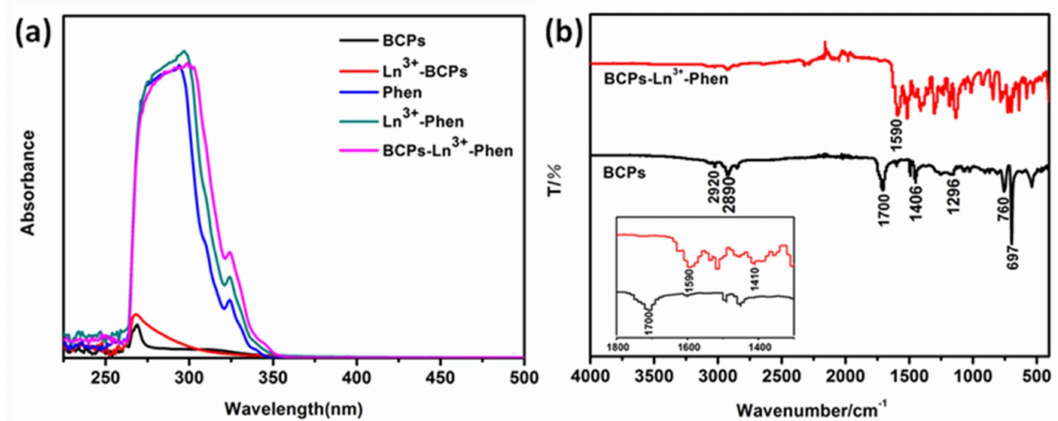
Figure 3. ( a ) UV-vis absorption spectra of BCPs, Ln 3+ -BCPs, Phen Ln 3+ -Phen, and BCPs -Ln 3+ -Phen; ( b ) FTIR spectra of BCPs and BCPs-Ln 3+ -Phen. Inset: the magnify spectra of